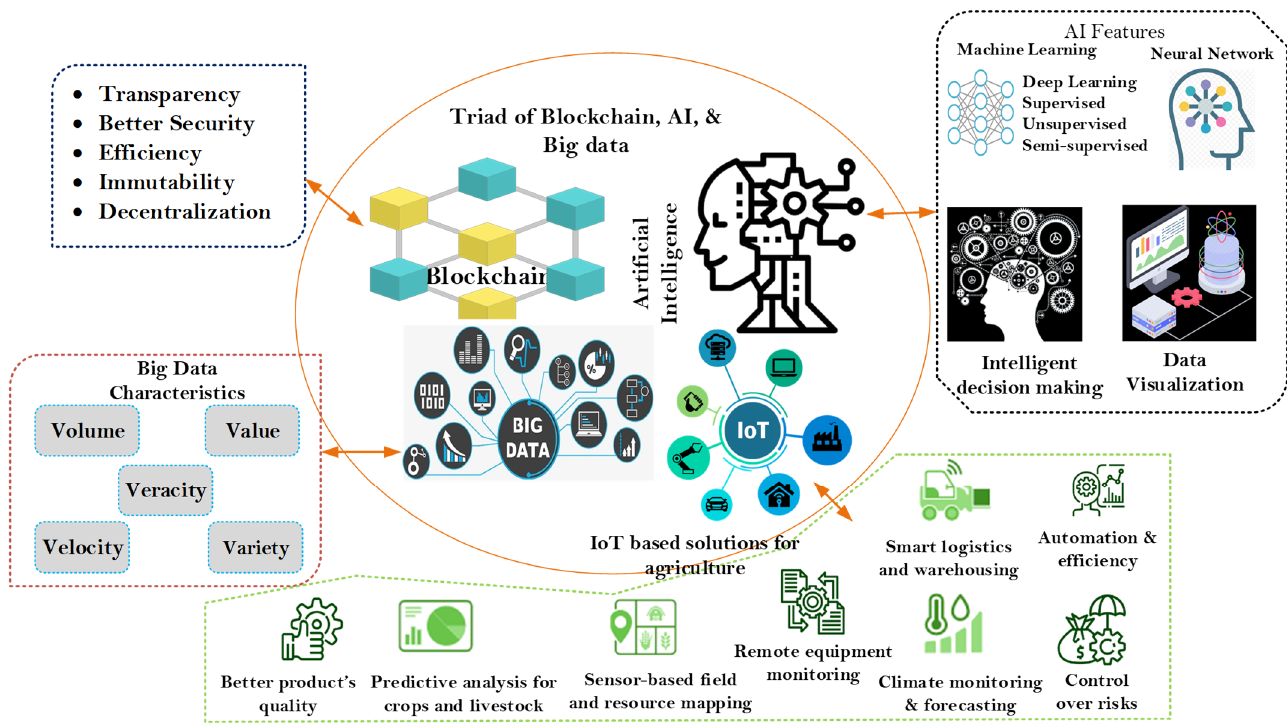
Figure 1. Characteristics of blockchain, AI, IoT, and big data for smart farming .